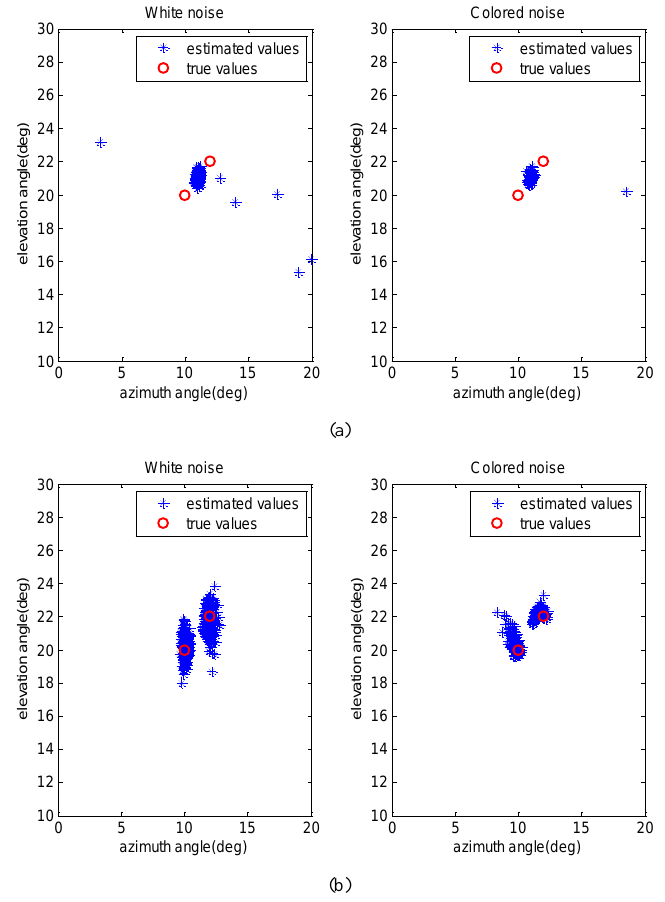
Figure 5. Comparison of resolution ability. ( a ) A-SDS method, ( b ) FB-ISD